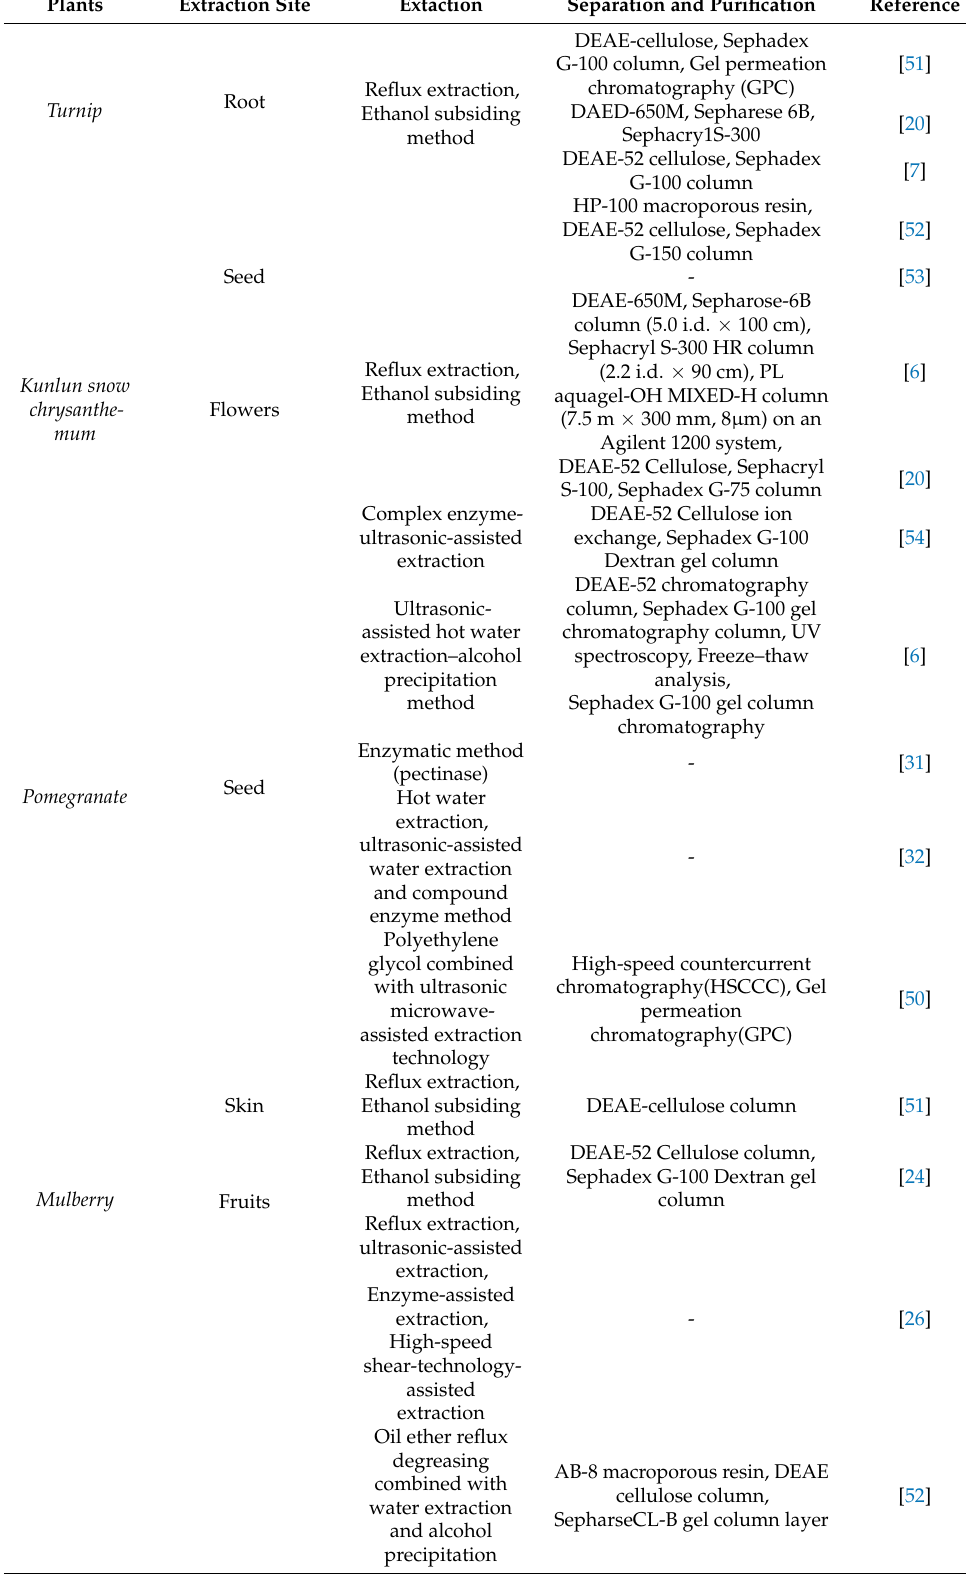
Table 3. Extraction and isolation methods of five plant